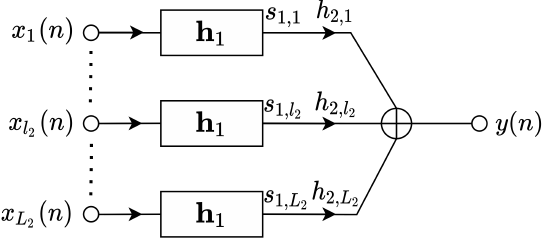
Figure 3. ( a ) The structure of s 1, l